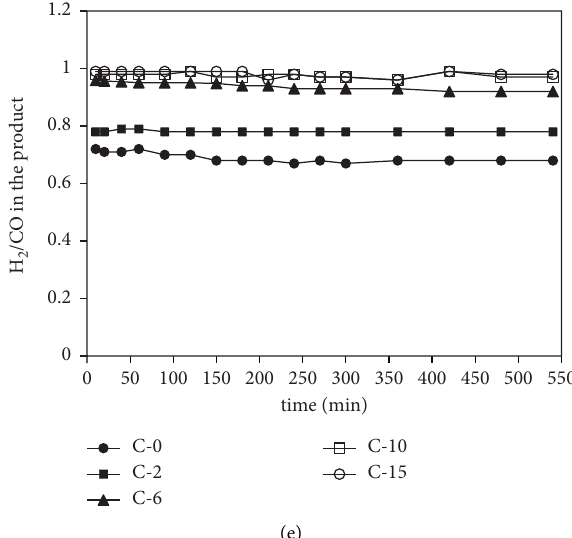
Figure 8: (a) Equilibrium conversion as a function of temperature. (b) Activity of pristine zirconia support within a temperature range of 600–800 ° C with GHSV 72000ml/hr · g cat . (c) Activity of synthesized catalysts in terms of %CH4 conversion as a function of time at a ). (d) Activity of synthesized catalysts in terms of %age CO 2 conversion as temperature ( T � 750 ° C, p � 1 bar, GHSV � 72000ml · h − 1 · g − 1 cat